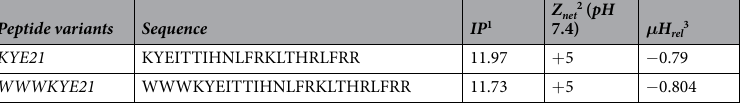
Table 1. Primary structure and key properties of the peptides investigated. 1 IP: isoelectric point; 2 Z net : net charge; 3 μ H rel : relative hydrophobic moment on the Kyte-Doolittle scale 45